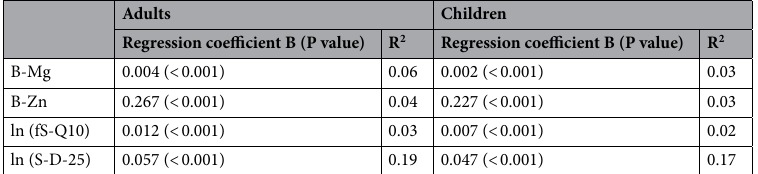
Table 2. The slope and the strength (coefficients of determination R 2 ) of linear trend for several